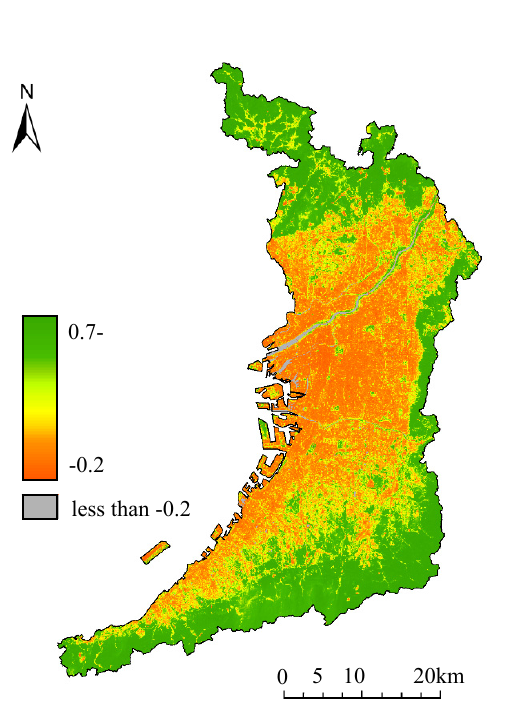
Figure 1. NDVI derived from Landsat OLS data from 2018